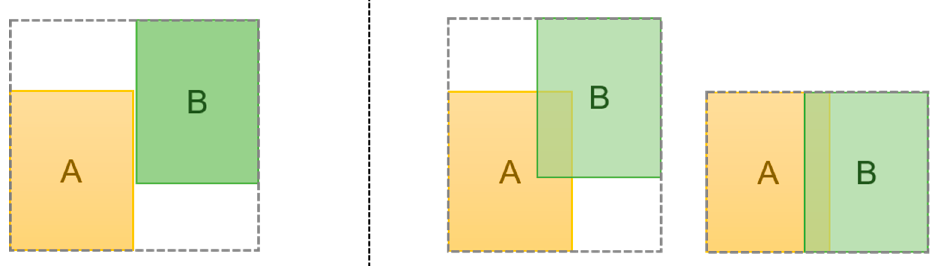
Figure 9. The left image shows the situation where two targets are not overlapped, the overlapped area is none, while the value of IoU will be zero. As shown in the right image, we can see two overlapped situations in that targets have the same overlapped area. That means these targets have the same IoU loss values and will regress in the same way. Obviously, the left situation will encounter more difficulties than the right.